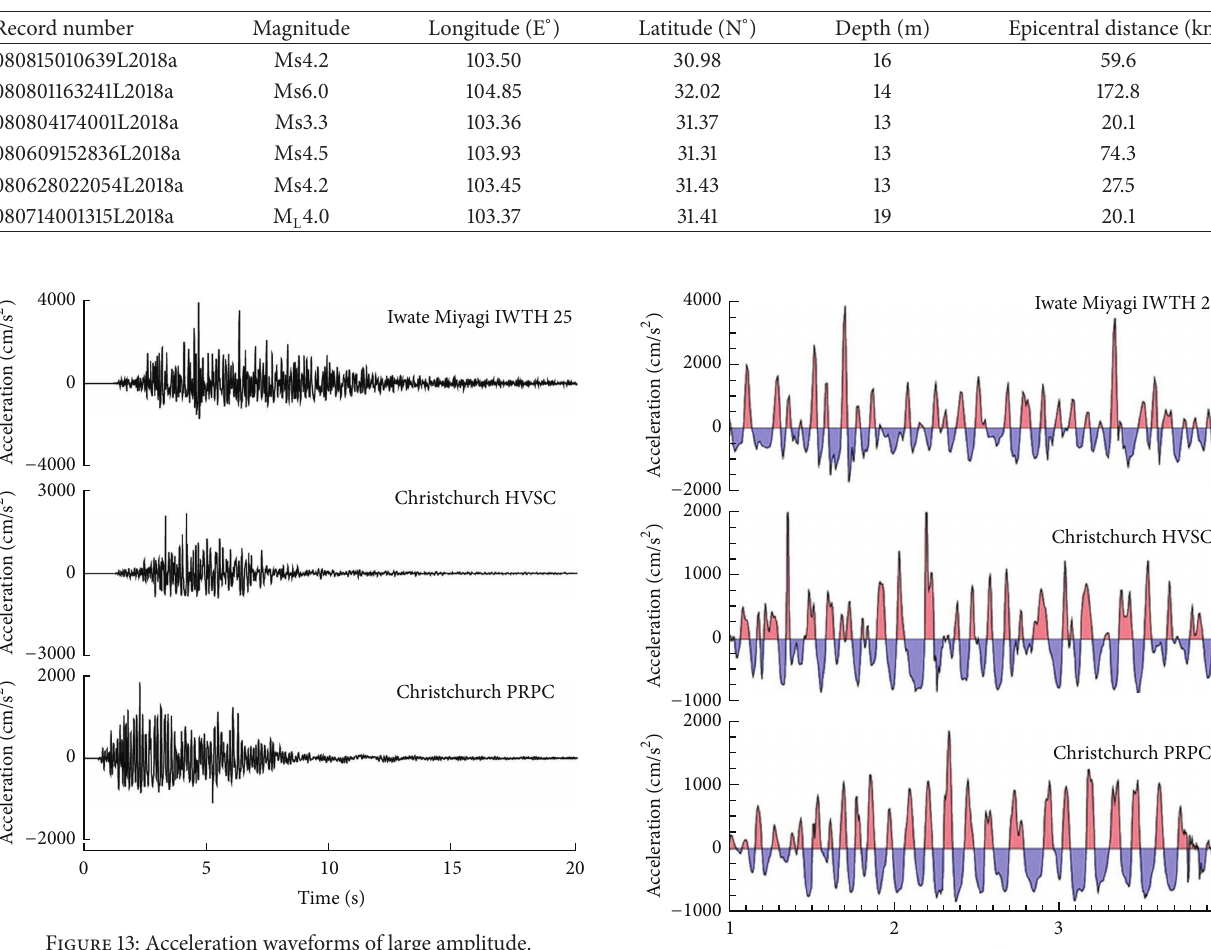
Table 4: The earthquake information corresponding to strong motion records.